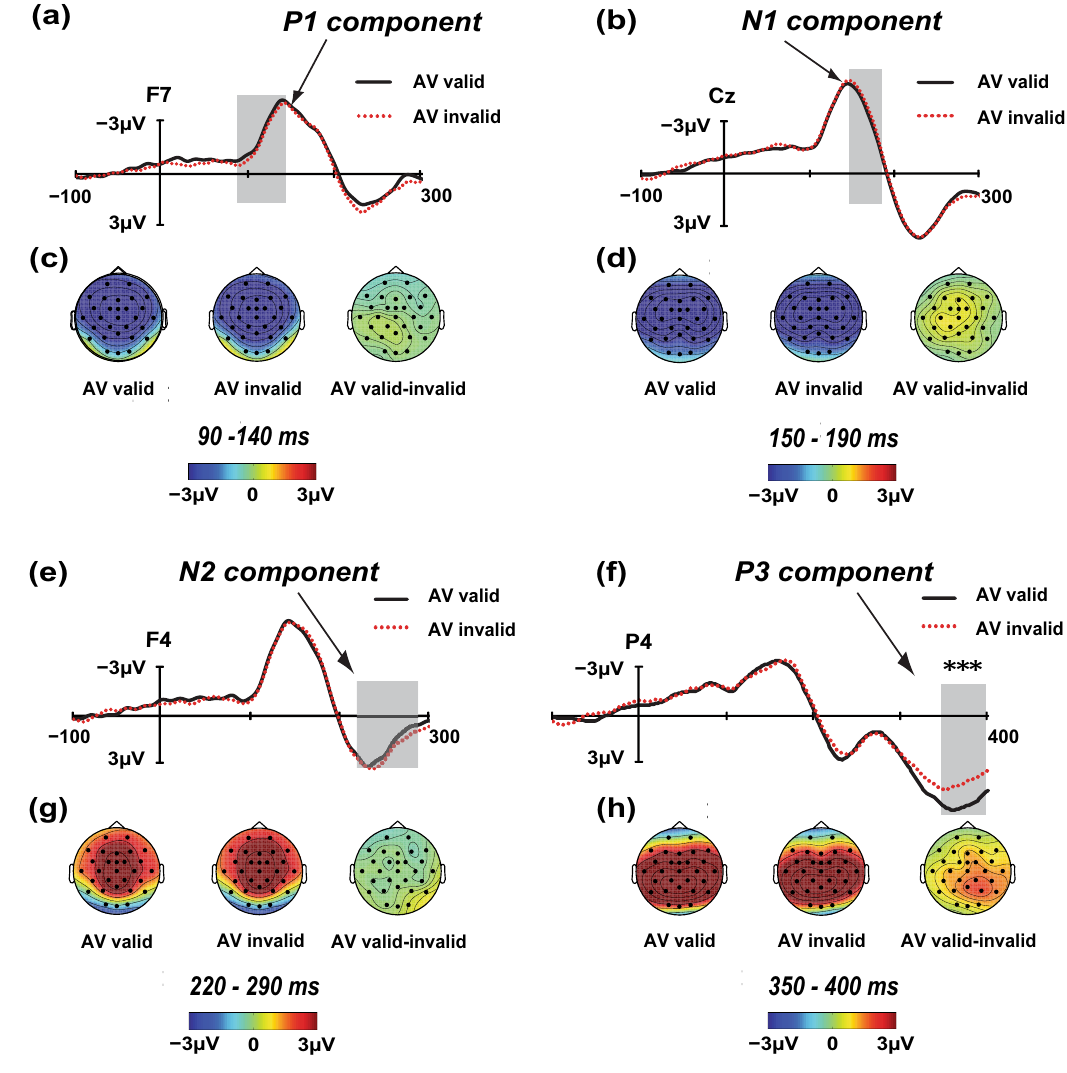
Figure 4. Direct comparisons of the audiovisual IOR effect for the time windows 90–140 ms, 150–190 ms, 220– 290 ms, and 350–400 ms. The contrasts between the valid and invalid locations were analysed using t test (sig. two-tailed; 95% confidence interval, CI), and the maximum difference between the valid and invalid locations is shown from F7 electrode, Cz electrode, and F4 electrode, for the P1, N1 and N2 components, respectively. The difference between the valid and invalid locations for the P3 component reaches significance in the P4 electrode (***p < 0.001). The grand average amplitudes elicited by the AV targets presented in either the valid (black solid) or invalid (red dotted) locations are shown in panels ( a ), ( b ), ( e ), and ( f ). The scalp topographies of the P1, N1, N2 and P3 components in the valid and invalid waveforms are shown in panels ( c ), ( d ), ( g ), and ( h ), respectively. Valid-invalid scalp topographies represent the IOR